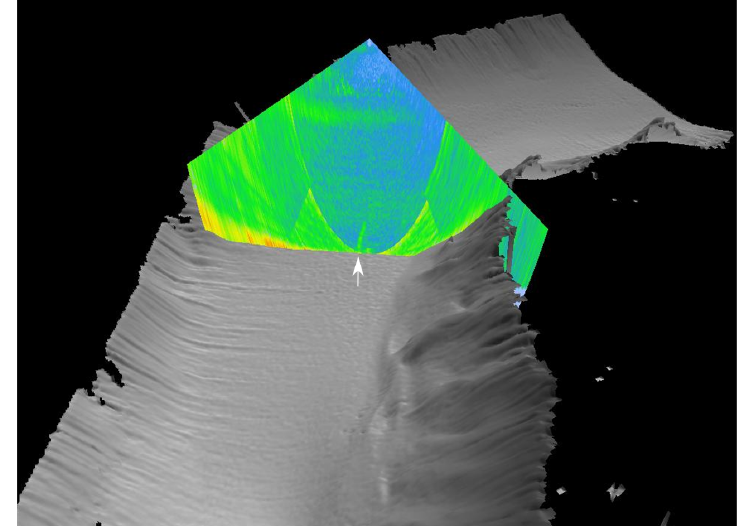
Figure 2. Multibeam imagery from the Hudson Canyon, acquired using the 30 kHz Kongsberg EM302 MBES mounted on the Sikuliaq research vessel. The bathymetric map of the canyon was obtained by concatenating more than one hundred pings (soundings). An acoustic backscatter image (beam fan) from a single ping shows a hydroacoustic flare indicating rising bubbles, near the center beam (indicated by the white arrow). The approximate rise height estimated from the acoustic backscatter image is around 80 m, which corresponds well with SBES observations (Figure 3a,b). This image was created using Fledermaus